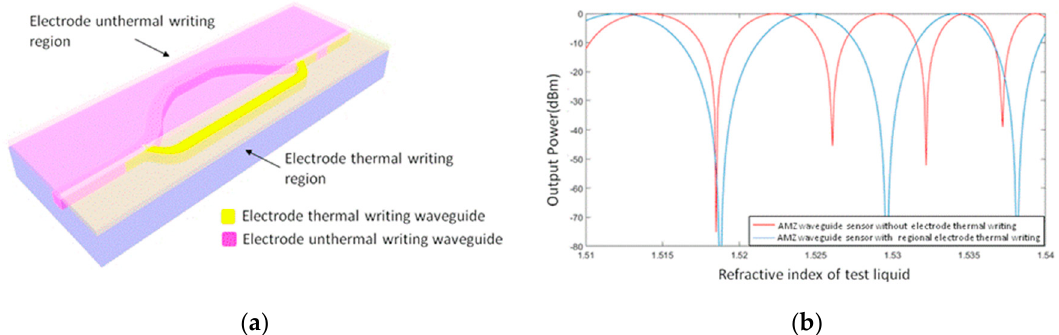
Figure 10. Schematics ( a ) and output power ( b ) of local electrode thermal writing device. Micromachines 2019 , 10 , x